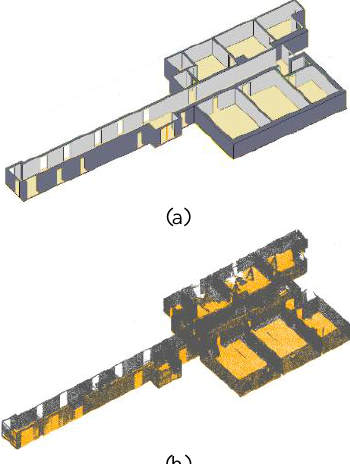
Figure 3. The ISPRS Benchmark dataset – TUB1: (a) the BIM with the visible surface marked as light grey; (b) the point cloud.